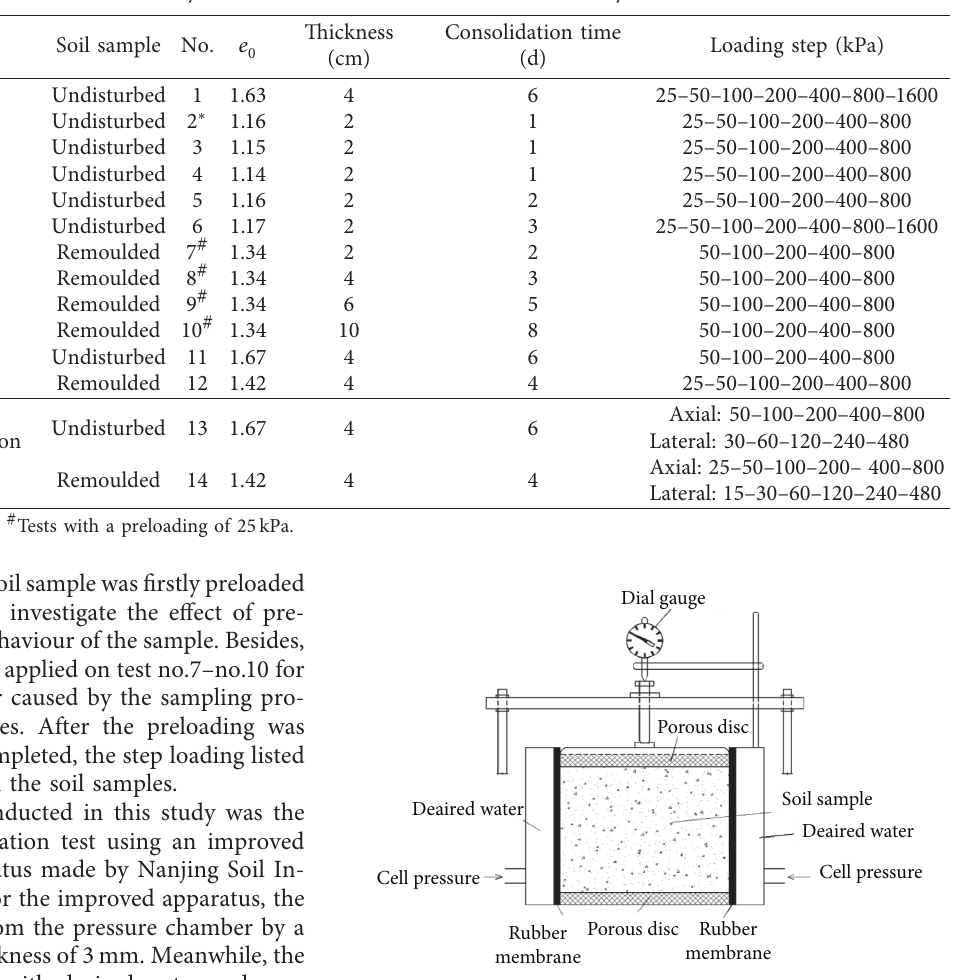
Table 2: Summary of consolidation tests conducted in this study.